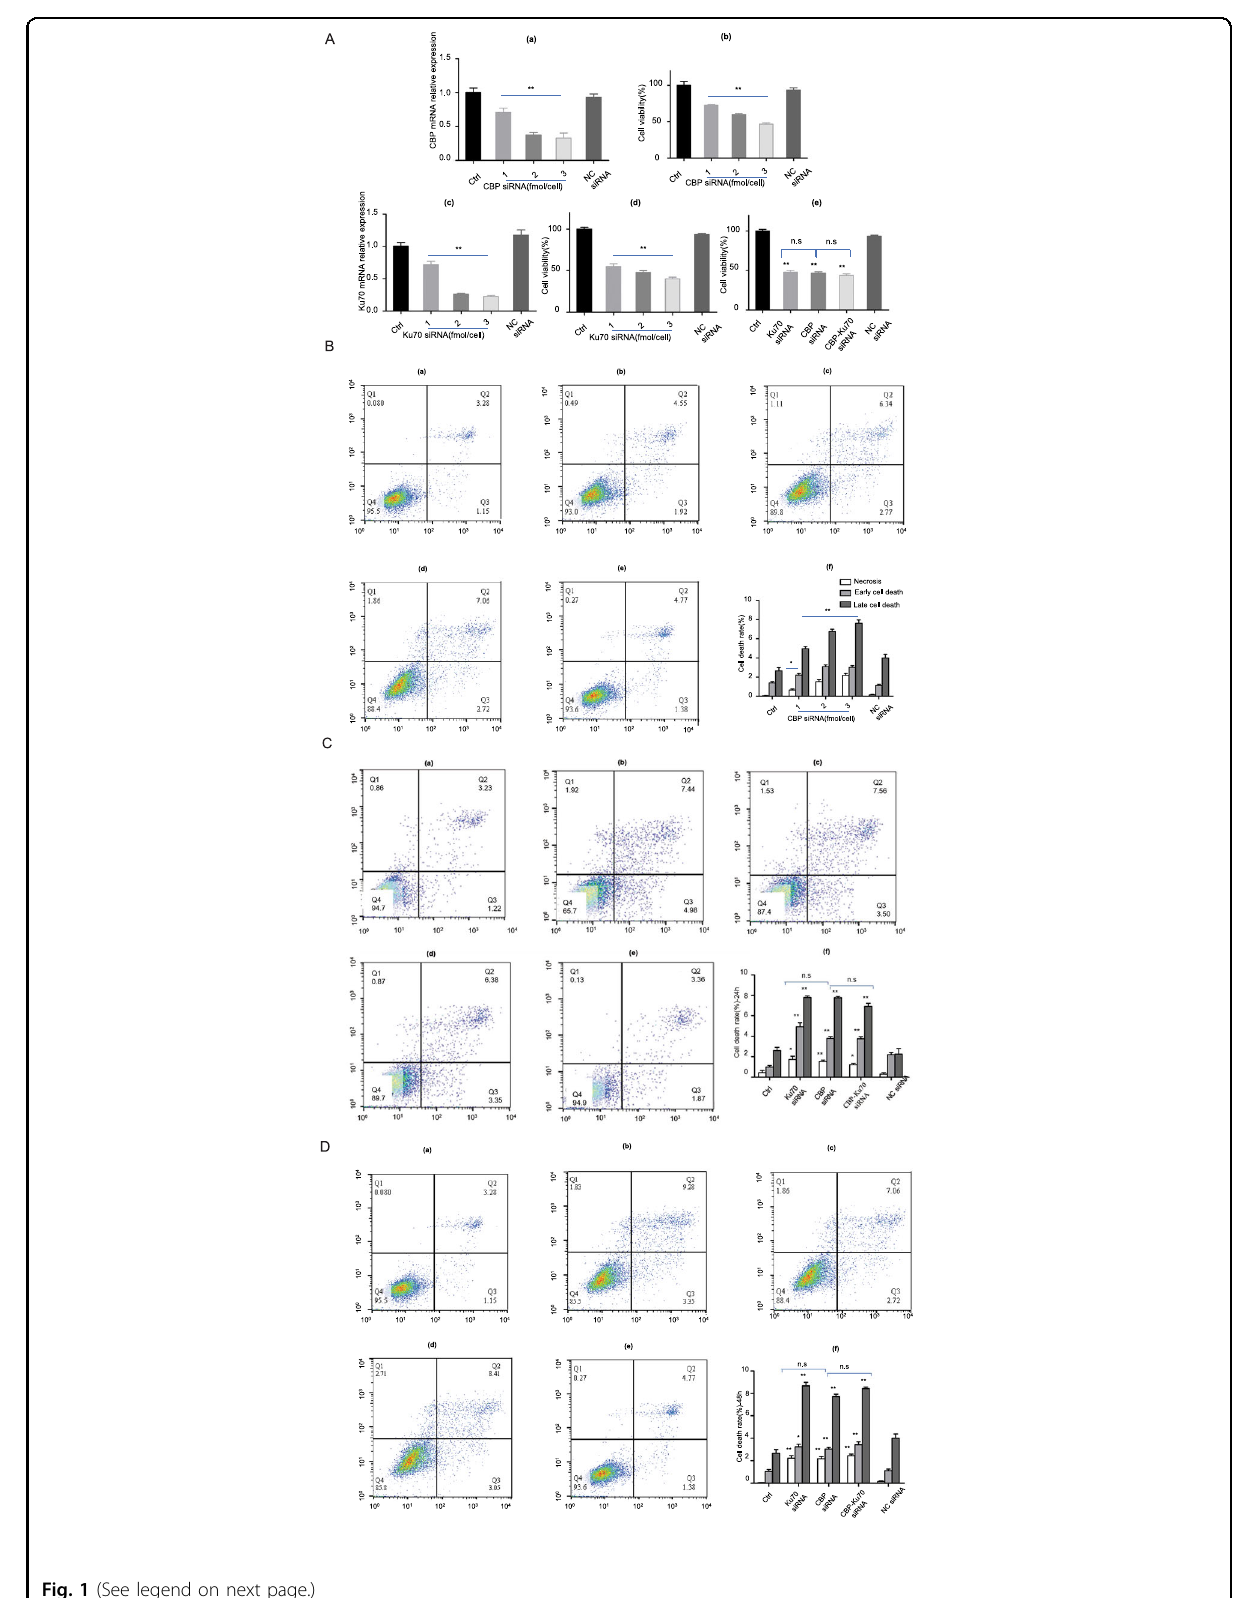
Fig. 1 (See legend on next